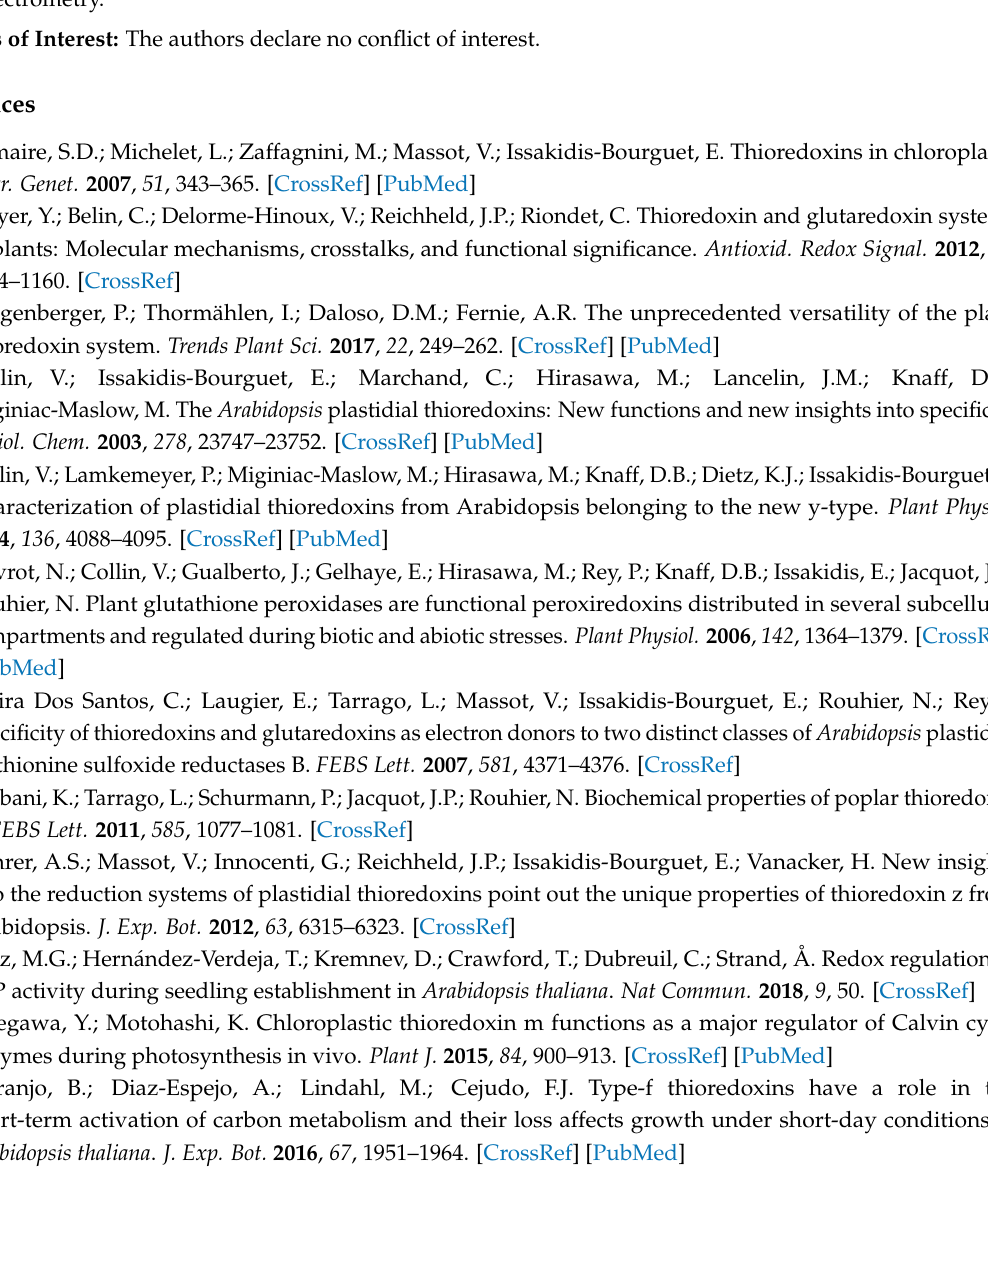
Figure S1. Effect of TRX treatments on NADH-dependent MDHAR activity in leaf extracts. Figure S2.